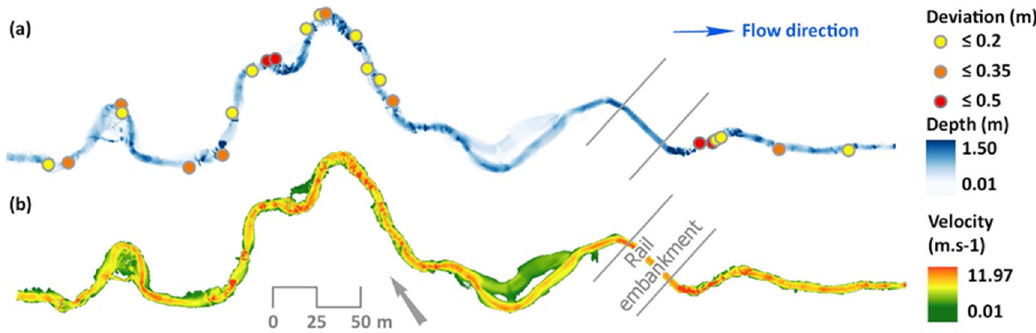
Figure 7. Raster outputs of hydraulic modelling for the Q optimum scenario: ( a ) water depth and ( b ) velocity. Colored circles illustrate the position of the 2014 PSI (scars) and deviations of their heights from the modelled flow.